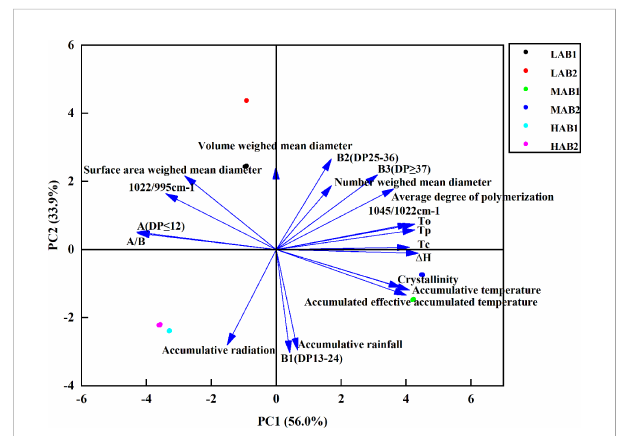
FIGURE 11 Principal Component Analysis of Potato Indicators at Different Altitudes. LA (low altitude), MA (middle altitude) and HA (high altitude stand for Chongzhou, Xichang and Litang respectively; B1 and B2 stand for Jiusen No. 1 and Qingshu No. 9 respectively.